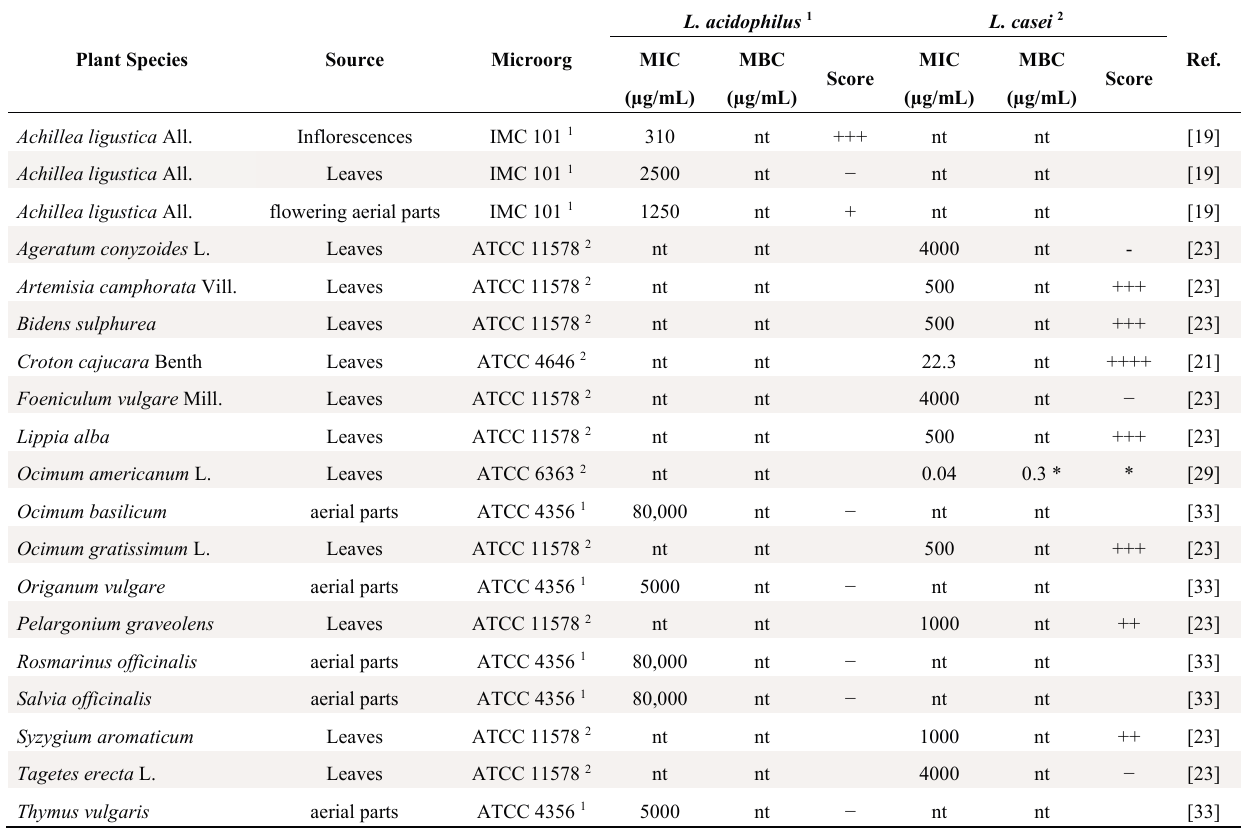
Table 3. In vitro antibacterial activity of essential oils against lactobacilli.